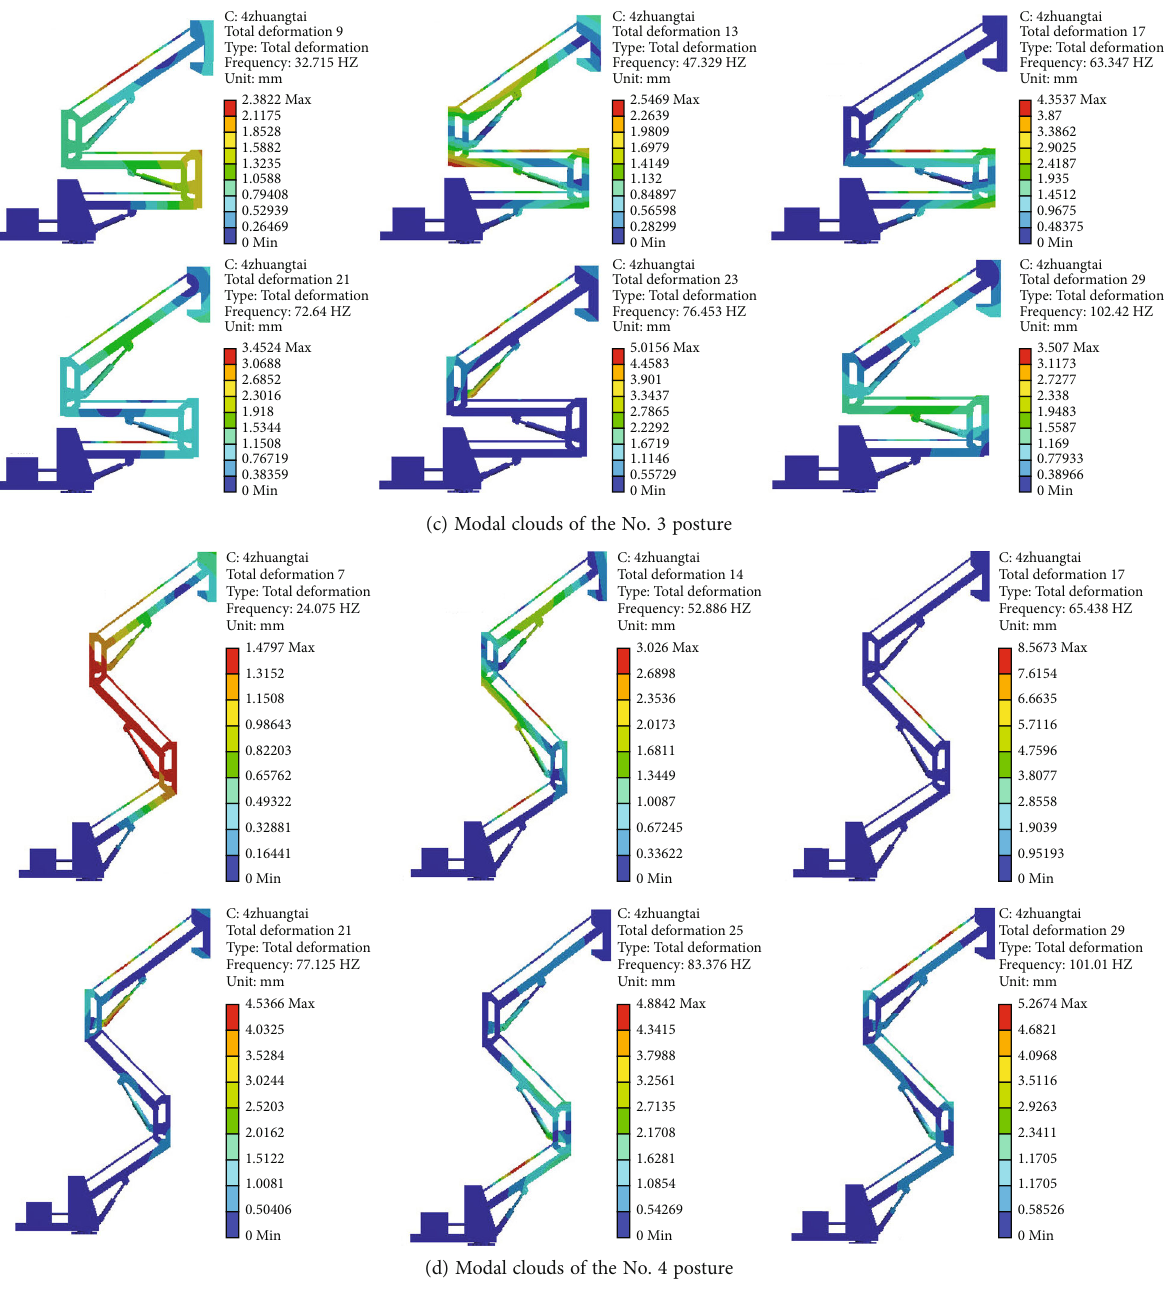
Figure 15: Vibration cloud fi gures of aerial working